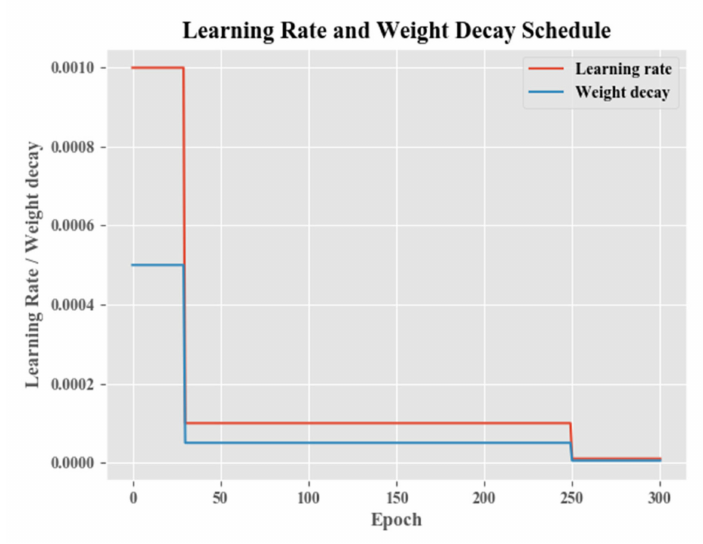
Figure 12. Learning rate and weight decay schedule curves.